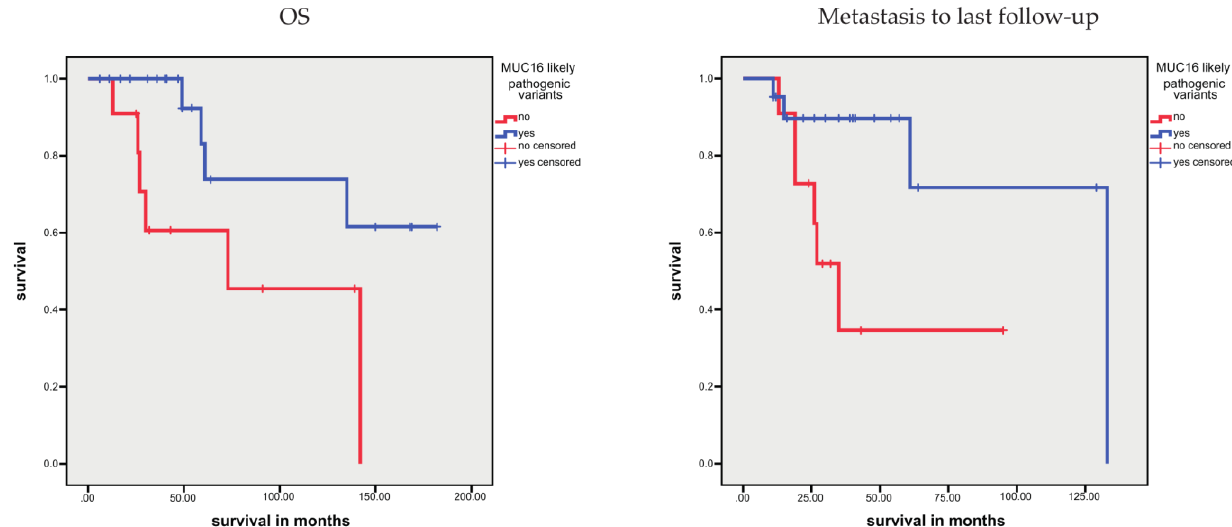
Figure 4. Kaplan–Meier analysis: association between MUC16 likely pathogenic sequence variants and OS or time of metastasis to last follow-up. Patients with likely pathogenic variants in the MUC16 gene showed a longer OS ( p = 0.028) and a longer survival time after diagnosis of metastasis ( p = 0.025).